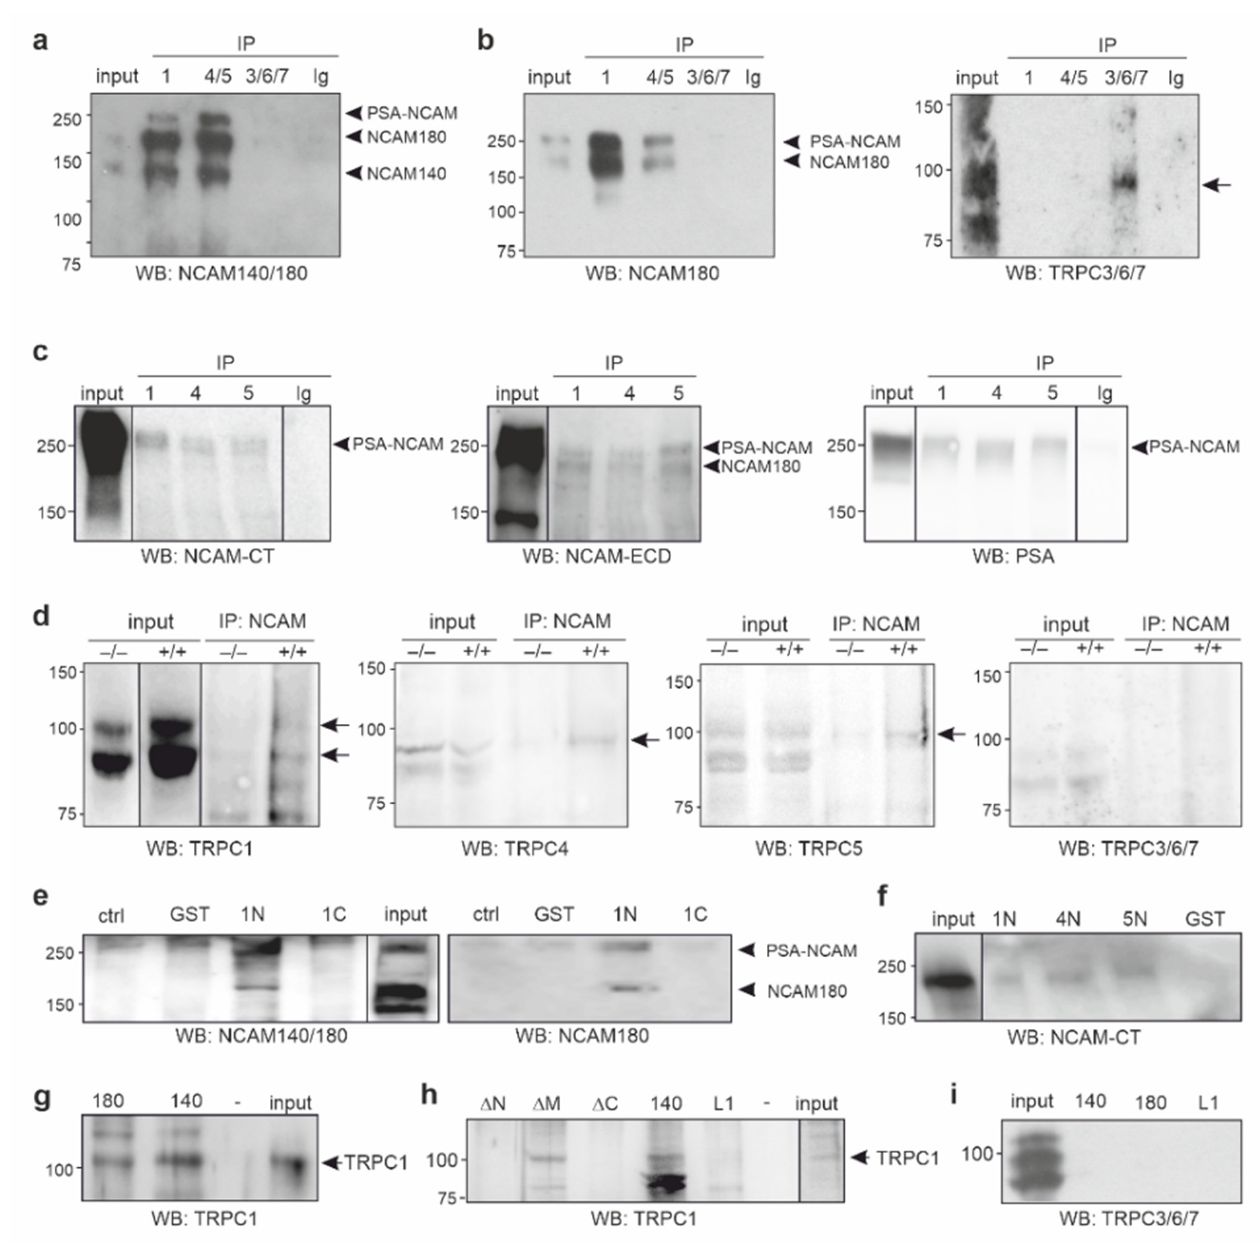
Figure 1. NCAM and TRPC1, − 4, and − 5 interact via their ICDs. ( a , b ) A brain detergent extract was used for immunoprecipitation (IP) with TRPC1 antibody H-105, TRPC4/5 antibody H-80 (4/5), TRPC3/6/7 antibody H-100 (3/6/7), and nonimmune control antibody (Ig). The brain detergent extract (input) and the immunoprecipitates were subjected to Western blot (WB) analysis with NCAM antibody 5B8 (NCAM140/180) ( a ), NCAM antibody D3 (NCAM180), or TRPC3/6/7 antibody H-100 (3/6/7) ( b ). ( c ) Detergent extracts of membrane-enriched brain fractions (input) and TRPC1 antibody ACC-010 (1), TRPC4 antibody ACC-018 (4), TRPC5 antibody ACC-020 (5), and a nonimmune control antibody (Ig) were used for immunoprecipitation, and the NCAM antibody GTX133217 against the C-terminus (NCAM-CT), a chicken antibody against the extracellular domains of NCAM (NCAM-ECD), and PSA antibody 735 (PSA) were used for Western blot analysis. ( a – c ) Arrowheads indicate bands representing NCAM140, NCAM180, and polysialylated NCAM140 and NCAM180 (PSA-NCAM), and the arrow indicates TRPC3, − 6, or − 7 bands. ( d ) Immunoprecipitation was carried out with brain detergent extracts (input) from wild-type (+/+) and NCAM-deficient ( − / − ) mice using NCAM antibody H28 and followed by Western blot analysis with TRPC1 antibody E-6 (1), TRPC4 antibody N77/15 (4), TRPC5 antibody N67/15 (5), and TRPC3/6/7 antibody H-100 (3/6/7). Arrows indicate TRPC1, − 4, or − 5 bands. ( e , f ) NCAM antibody 5B8 (NCAM140/180), D3 (NCAM180) ( e ), and GTX133217 (NCAM-CT) ( f ) were used for Western